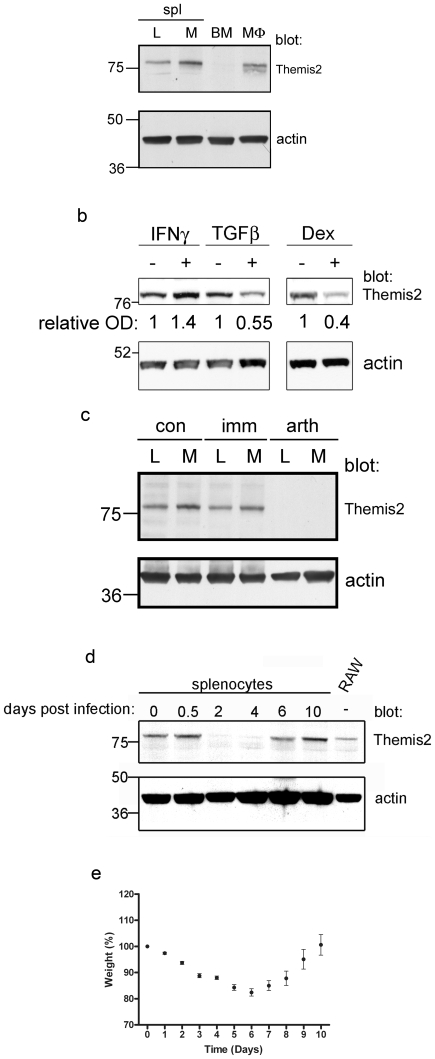
Regulation of Themis2 expression.In panels a–d, detergent extracts of matched numbers of cells were western blotted for Themis2 and actin. Data are representative of three similar experiments. Panel a. Whole splenocytes were separated into non-adherent (lymphocyte-enriched, L) and adherent (macrophage-enriched, M) populations; bone marrow cells undifferentiated (BM) or M-CSF-differentiated macrophages (MΦ). Panel b. RAW cells were treated (48 hrs) with or without IFNγ (10 ng/ml), TGFβ (20 ng/ml) or dexamethasone (0.1 µM). The relative levels of expression in this experiment, corrected for actin expression levels, are presented below each lane. A representative of three similar experiments is presented. Panel c. Lymphocyte-enriched (L) or macrophage-enriched (M) splenocyte populations were recovered as above from control mice (con), immunised but disease-free mice (imm) or immunised arthritic mice (arth) 10 days after immunisation with type II collagen. Panels d,e. Mice (5 per time point) were inoculated (50HAU of X31 influenza, nasally) or not, weighed and splenocytes recovered at the indicated time points. Weight (mean±sem) is expressed as a percentage of the value measured at time zero for each animal.